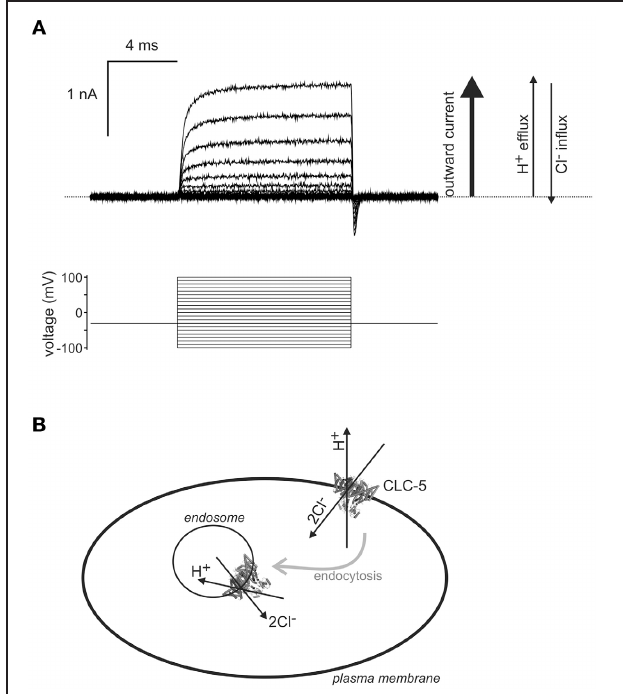
FIGURE 1 | Biophysical properties suggest transport of H + into endosomes by CLC-5. (A) A family of CLC-5 currents recorded from a transfected HEK293 cell by the whole-cell patch-clamp technique. The dotted line represents the zero current baseline. Pulses were applied from − 100 to + 100mV as illustrated by the voltage protocol. Only outward currents (upward currents from the baseline), corresponding to H + efflux and Cl − influx, are observed with CLC-5 expressed at the cell surface, indicated by the arrows to the right of the currents. Ion flux in the opposite direction would be recorded as inward currents (downward deflection from baseline) and these were not observed under all [Cl − ] and pH conditions tested (Smith and Lippiat, 2010a). The transient inward currents upon repolarization are gating currents and do not involve ion transport across the membrane (Smith and Lippiat, 2010b). (B) If this property persists in endosomal membranes then a Cl − gradient, which may occur immediately upon endocytic vesicle formation, may drive the transport of H + into endosomes by CLC-5. It is assumed that the arrangement of transmembrane and intracellular domains of CLC-5 are consistent between plasma and endosomal membranes, as indicated by the representation of the crystal structure of a homologous eukaryotic CLC transporter (Feng et al., 2010). Ion transport through one subunit of the dimer is indicated by the arrows and the proteins and could provides the H + -ATPase-independent acidification component identified by (Smith and Lippiat, 2010a). Other transporters and membrane proteins that colocalize with CLC-5 are omitted from this cartoon.